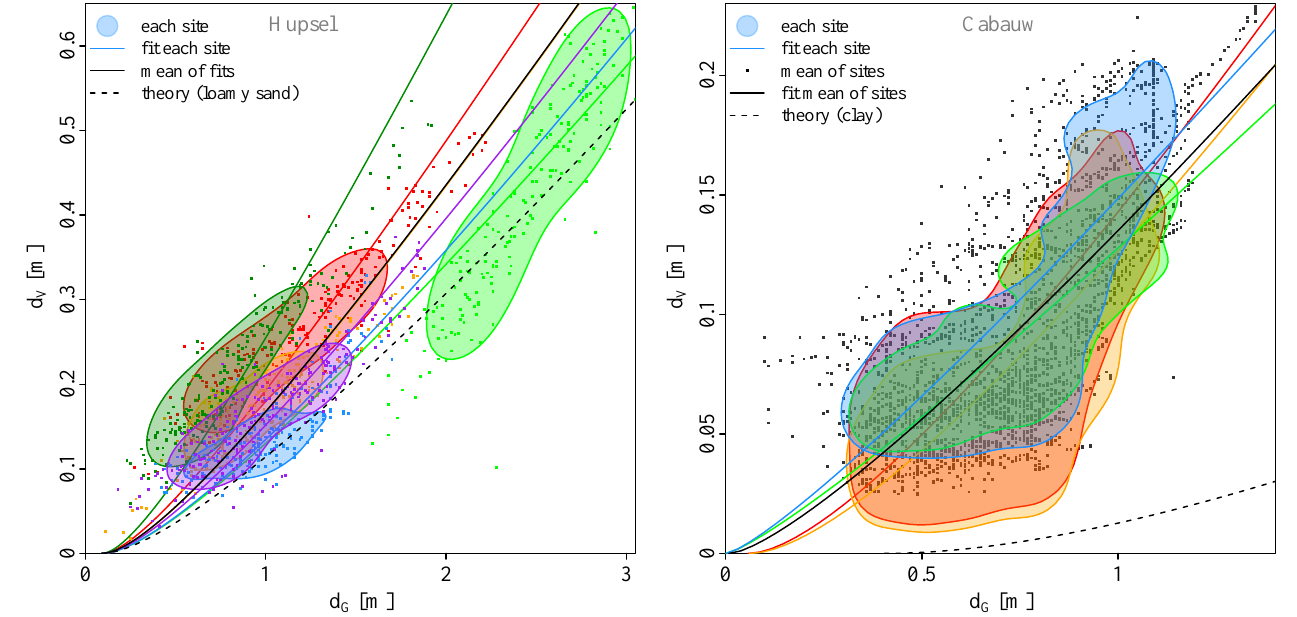
Fig. 7. Relation between groundwater depth d G and storage deficit d V . Coloured lines: data from six and four sites in the two catchments. Dashed black line: relation derived from the Brooks–Corey curve belonging to loamy sand (left) and clay (right). Coloured lines: relation with b fitted on data. Solid black line: relation with the average b of the stations. The clouds are represented by the contour lines encompassing 70 % of the probability mass estimated using kernel densities (Wand and Jones, 1995).